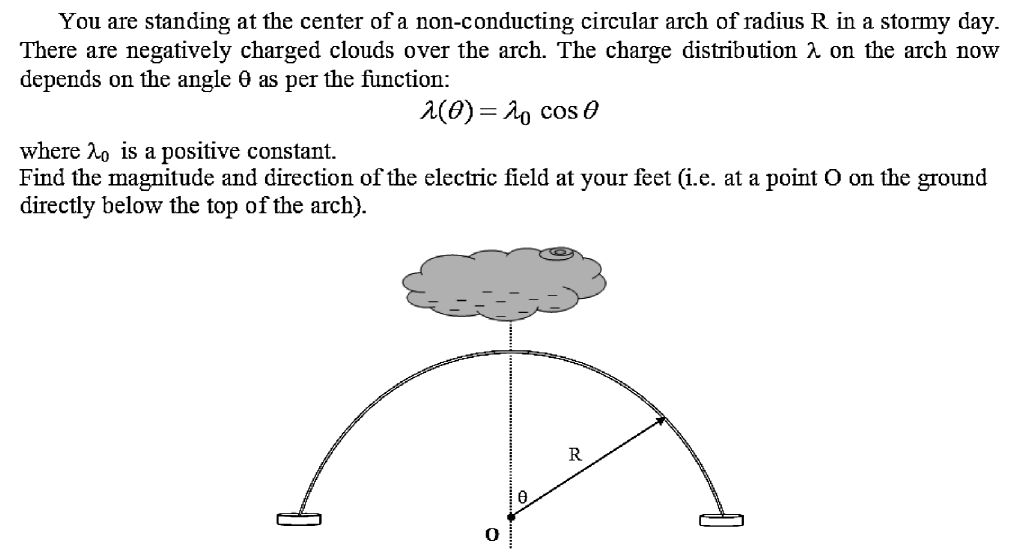
FIG. 1. The charged arch problem (interview 5).